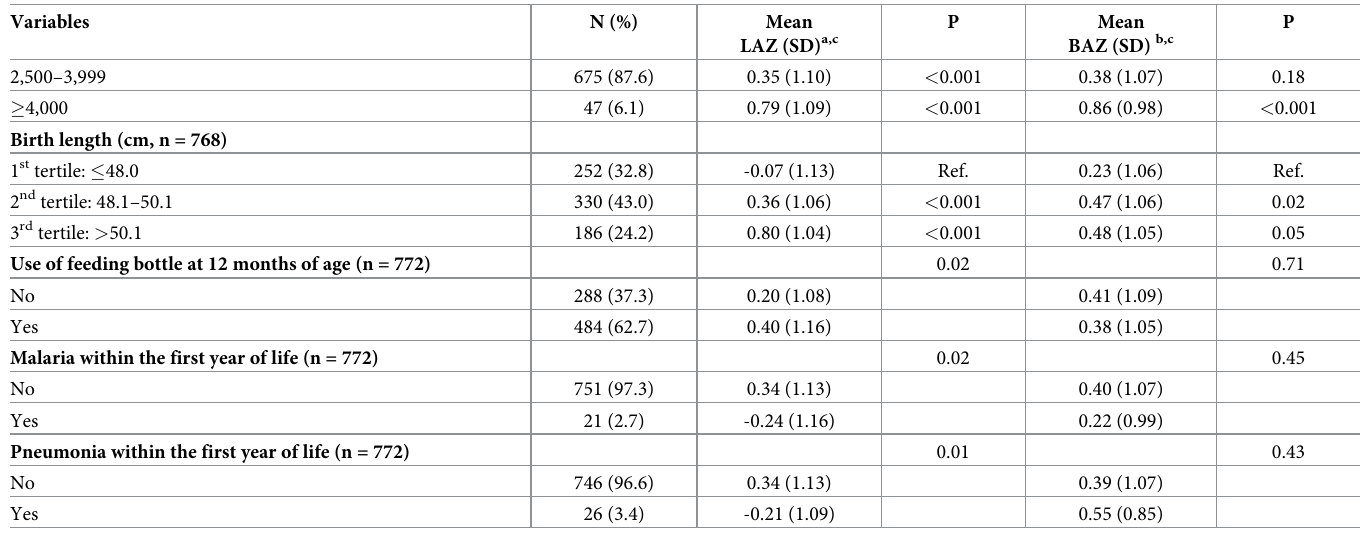
BAZ: BMI-for-age Z score, calculated according to the WHO growth standards (WHO, 2006). c Comparison of anthropometric indices according to the categories of exposure variables using unpaired t-tests for dichotomous variables and analysis of variance with Bonferroni post-hoc test for ordinal